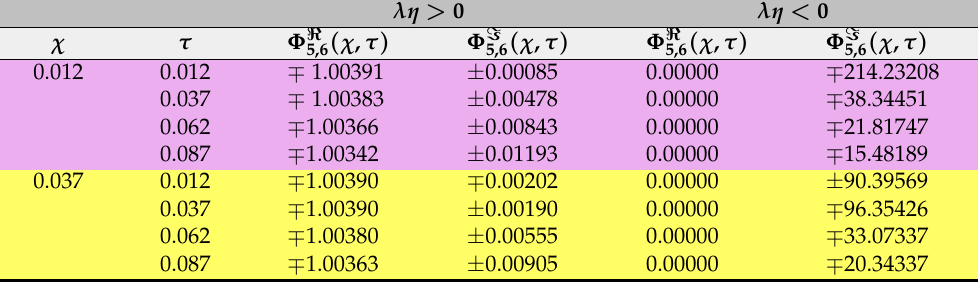
Table 3. The imaginary and real parts of the analytical solutions of Equation (4) are obtained by the G (cid:48) expansion method, with diverse point sources, though arbitrary, and α = G 2 −